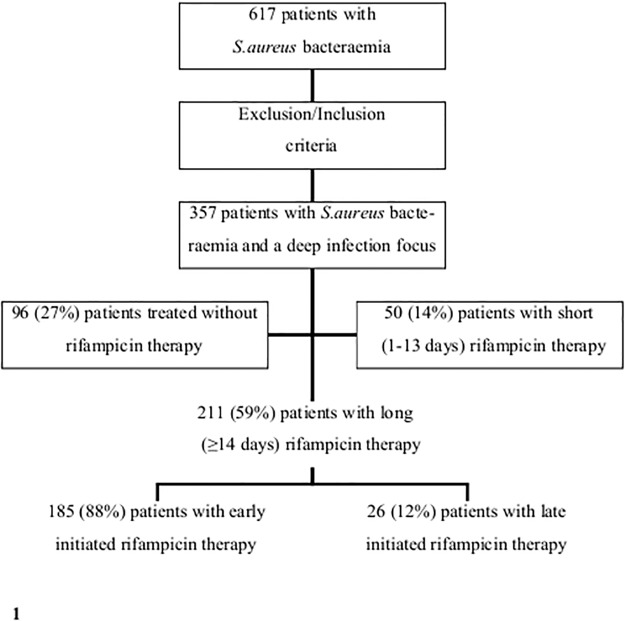
Study profile. Originally 617 patients with methicillin-sensitive S. aureus bacteraemia were identified.Patients with methicillin-resistant S. aureus bacteraemia were not included in the study (n = 6). The exclusion criteria were: patients with fatal outcome within 3 days of positive blood cultures, patients with alcoholism, acute or chronic liver diseases and patients without a deep infection foci. In total, 260 patients were excluded and altogether 357 patients were left for the analyses. Early initiation of rifampicin therapy was defined as an initiation within 7 days of positive blood cultures whereas late initiation of rifampicin therapy was defined as an initiation 7 days past positive blood cultures.